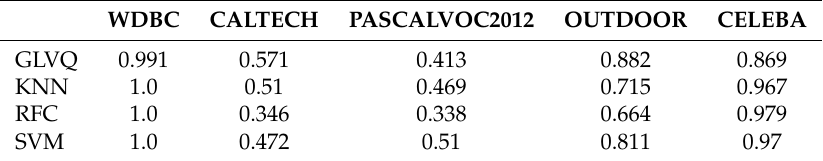
Figure 9. Ground-truth accuracy and estimated accuracy of the GLVQ classifier trained on the OUTDOOR data set for both random sampling and uncertainty sampling and both train and test set. Table 7. Final classifier accuracies of real-world uncertainty sampling